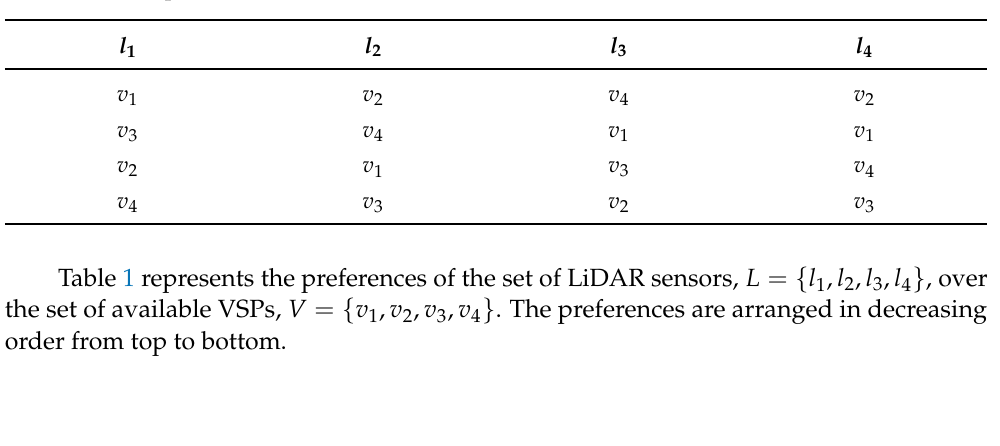
Table 1. LiDAR preferences over